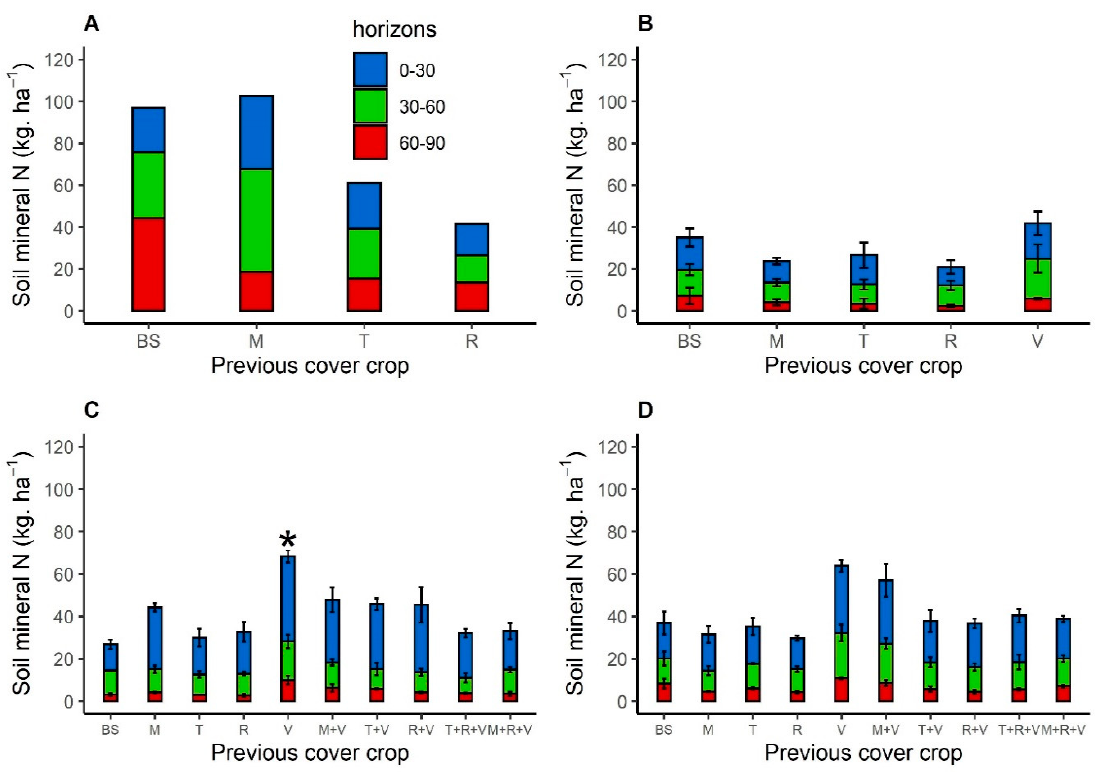
Figure 4. Soil mineral nitrogen (kg ha − 1 ) in the three depth soil horizons (0–30, 30–60, and 60–90 cm) measured at sunflower sowing in 2016 ( A ), 2017 ( B ), 2019 ( C ) and 2020 ( D ) after bare soil, Brassicaceae, and Fabaceae cover crops sown in sole crops ( A – D ) or a mixture ( C , D ) with one Brassicaceae and one Fabaceae, or two Brassicaceae and one Fabaceae. Abbreviation letter refers to BS for bare soil, M for brown mustard, T for turnip rape, R for fodder radish and V for purple vetch. Error bars represent standard errors. There were no blocks in 2016. Soil mineral nitrogen that differed significantly from that of bare soil are indicated by * ( p < 0.05).